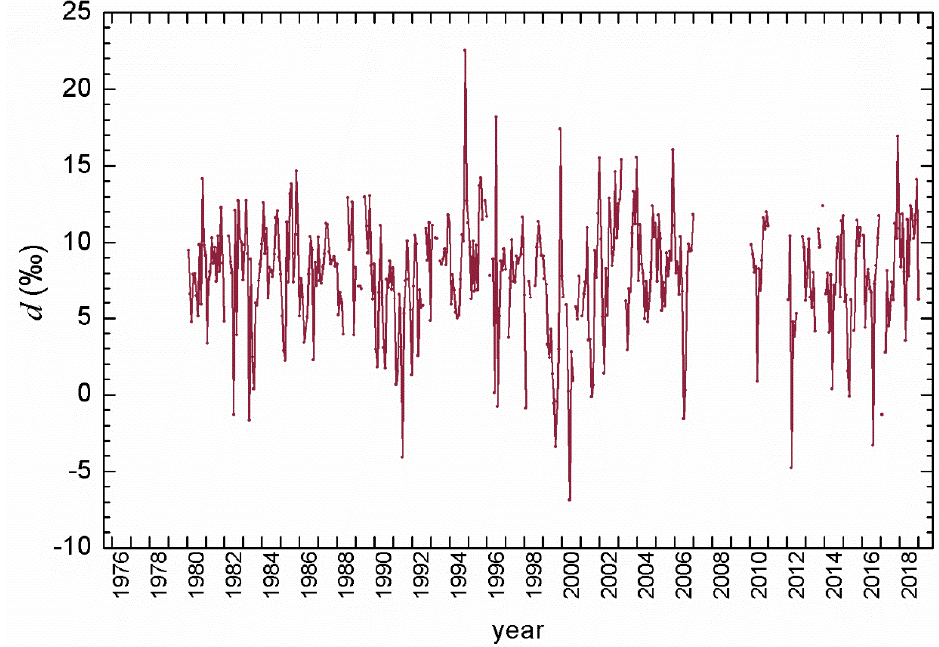
Figure 4. Monthly deuterium excess values for precipitation at Zagreb, 1980–2018.